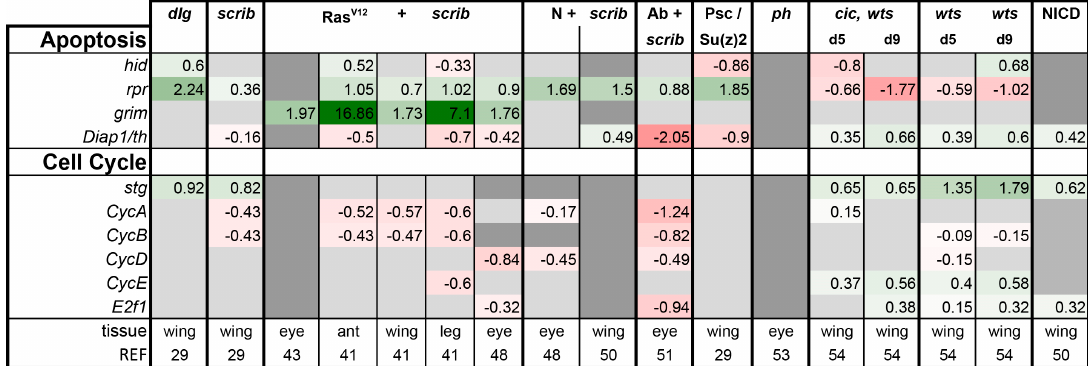
Figure 9. Expression of genes involved in apoptosis and cell cycle across tumors. Gene expression is displayed in log2FC. Color coding corresponds to a heatmap with a scale from − 5 (dark red) to 5 (dark green). Light grey cells represent non-significant changes with p ≥ 0.05. Dark grey: the gene was not found in the datasets. Abbreviations: head involution defective, hid; repear, rpr; thread, th; string, stg; Cyclin A, CycA; E2F transcription factor 1, E2f1